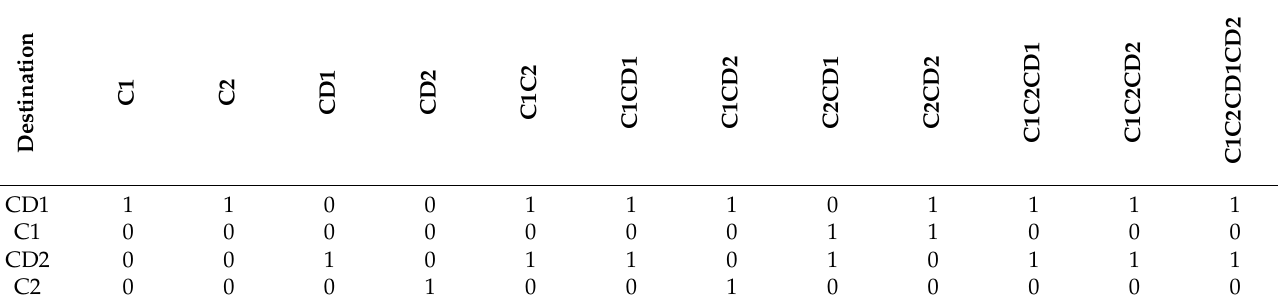
Table 4. Truck movement matrix at